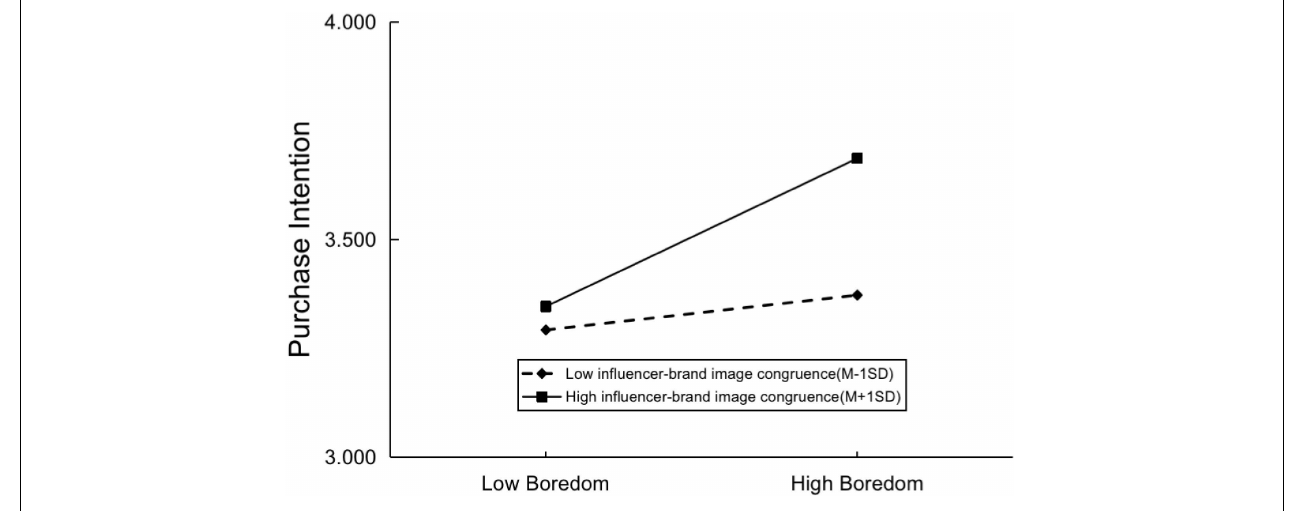
FIGURE 2 | Showing